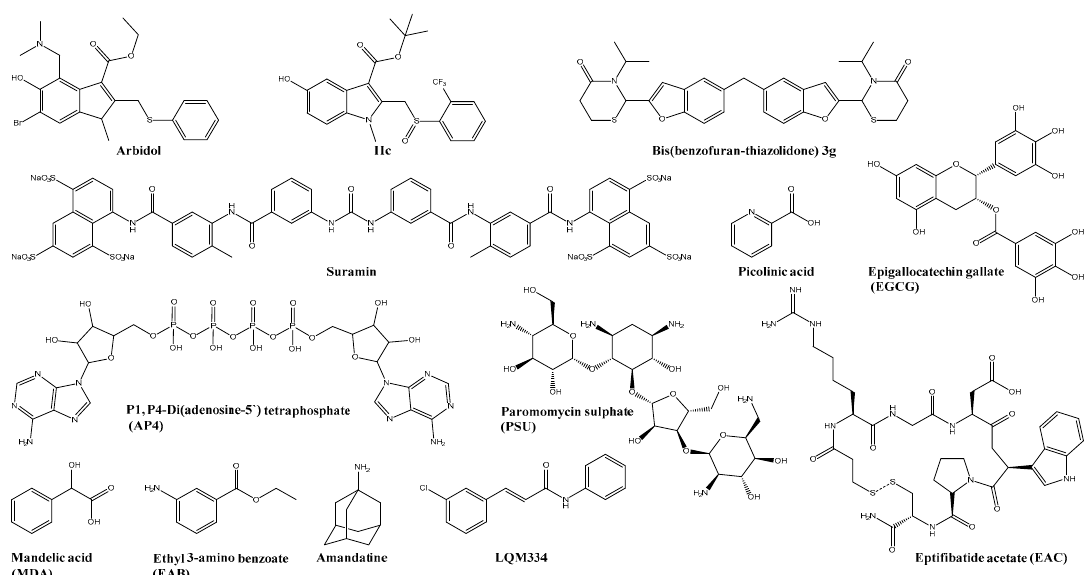
Figure 1. Chemical structure of virus-targeting compounds. Inhibitors of viral entry and membrane fusion: arbidol, IIc, suramin, epigallocatechin gallate, bis(benzofuran-thiazolidone) 3g, and LQM334. Inhibitor of the viral capsid protease: picolinic acid, mandelic acid, ethyl 3-aminobenzoate, P1, P4-di(adenosine-5 ′ ) tetraphosphate, eptifibatide acetate, and paromomycin sulphate. Inhibitor of 6K Protein: amantadine.